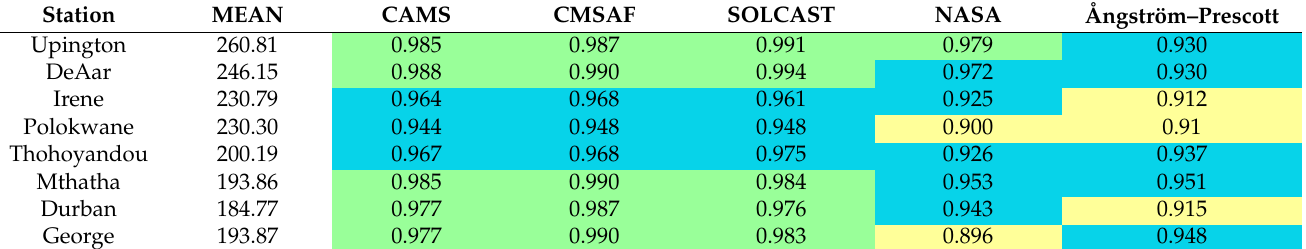
Figure 5. The daily rMAE of the estimated GHI datasets under all-sky conditions. Table 3. The daily average observed GHI (W/m 2 ) and the correlation (R 2 ) between the estimated datasets and the observed GHI in all-sky conditions. Green is the best (R 2 > 0.975), blue is the inter-